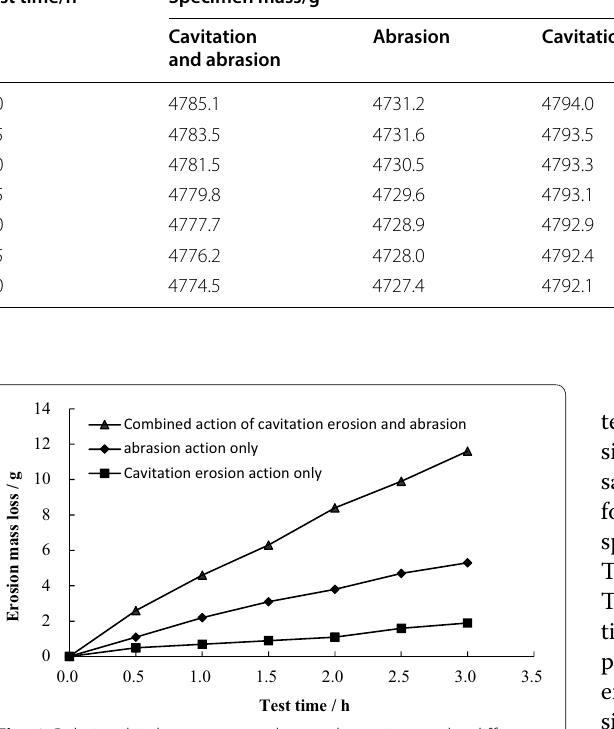
Fig. 6 Relationship between wear loss and test time under different action